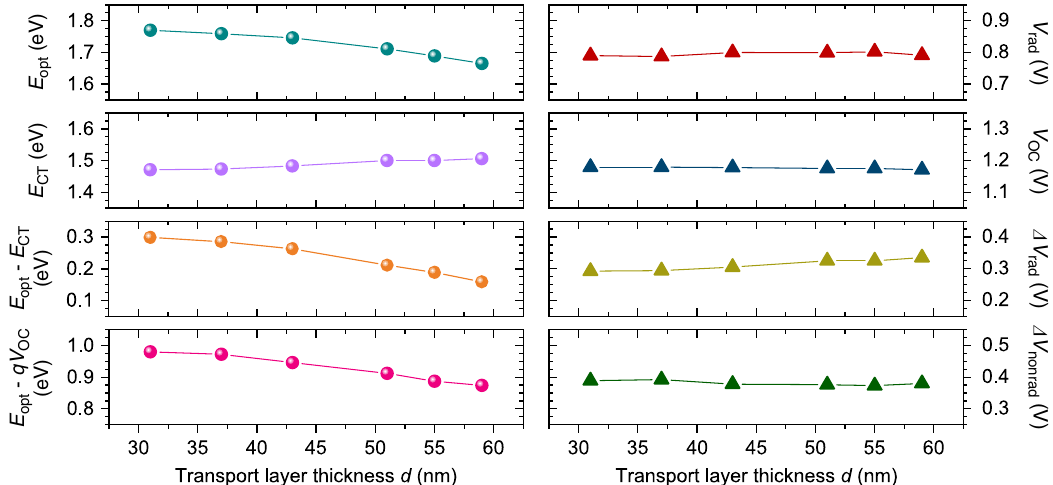
Fig. 4 Voltage and energy losses of SubNc/C 60 SC-devices with varying transport layer thickness d . The E opt of the devices corresponds to the peak of the LP branch λ peak (Fig. 3a), and E CT is determined from the crossing point between appropriately normalized reduced EQE and EL spectra (Fig. 3b), which is found to be approximately the same for the investigated devices. With increasing transport layer thickness, the driving force ( E opt – E CT ) and the total energy losses ( E opt – qV OC ) decrease. Δ V rad and Δ V nonrad correspond to the voltage losses related to radiative and non-radiative recombination, respectively, and